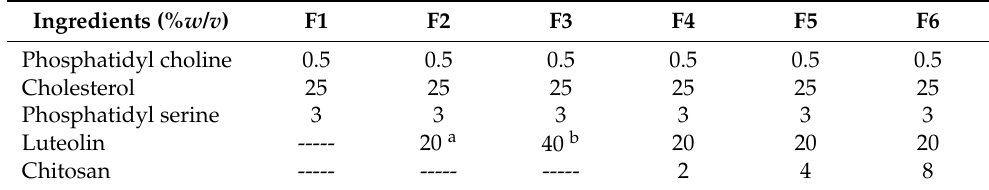
Table 1. The composition of various formulations of empty and Luteolin-loaded anionic liposomes, and chitosan coated liposomes (Chitosomes) prepared by ethanol injection method. Ingredients (% w / v ) F1 F2 F3 F4 F5 F6 Phosphatidyl choline 0.5 0.5 0.5 0.5 0.5 0.5 Cholesterol 25 25 25 25 25 25 Phosphatidyl serine 3 3 3 3 3 3 Luteolin ----- 20 a 40 b 20 20 20 ----- ----- 2 4